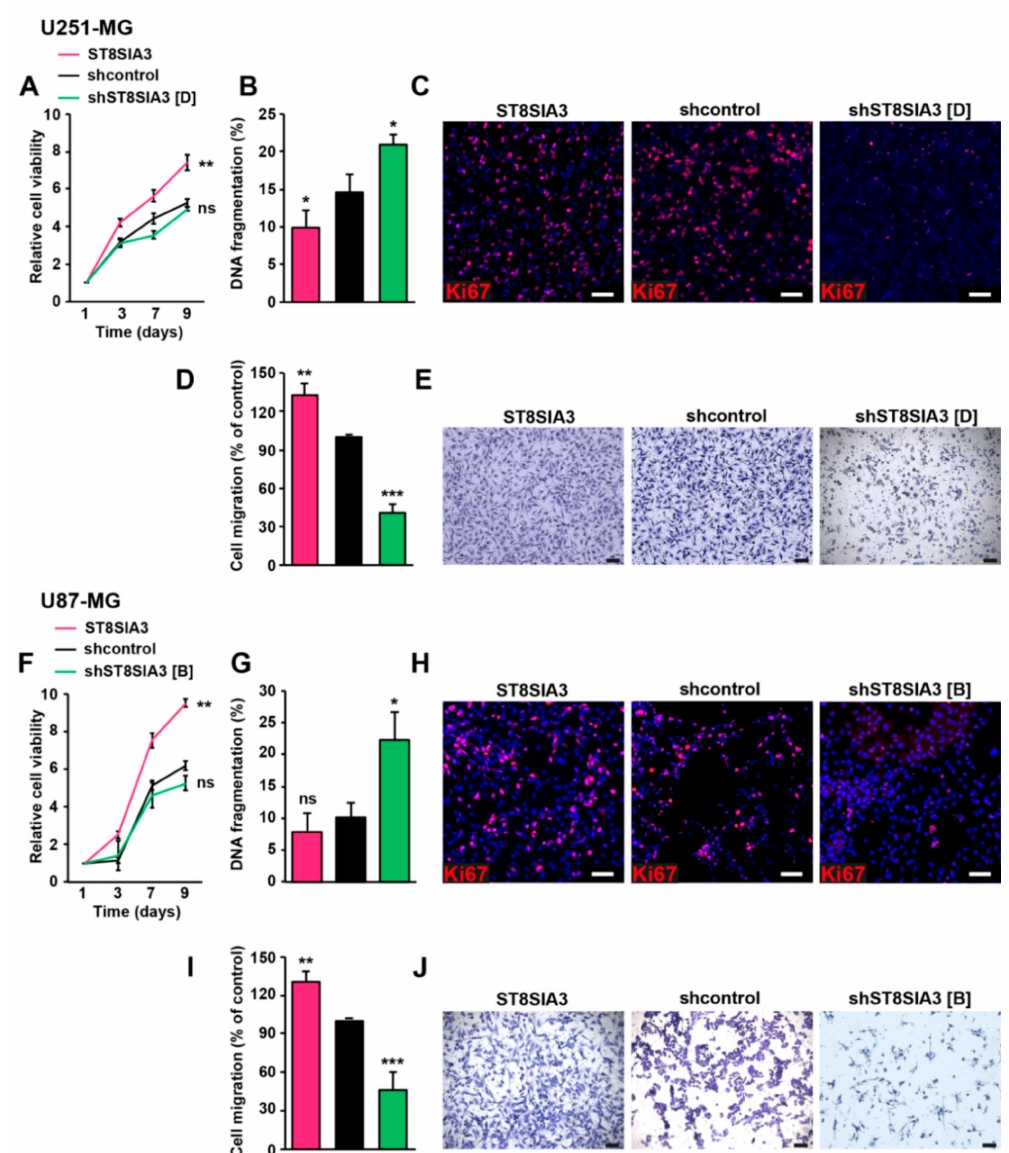
Figure 2. ST8SIA3 modulates in vitro cell death, proliferation, and migration. ( A , F ) Colorimetric MTT assay (3-(4,5-dimethylthiazol-2yl)-diphenyl tetrazolium bromide) was performed to compare cell viability ( n = 5 for each cell line). ( B , G ) DNA fragmentation (sub / G 1 ) was determined by flow cytometry of propidium-iodide-stained nuclei. Data are expressed as mean ± SEM deduced from five independent experiments. ( C , H ) Immunofluorescence staining of the proliferation marker Ki67 (red) in ST8SIA3, shcontrol, and shST8SIA3 cell lines. Cell nuclei are counterstained in blue. Scale bar = 50 µ m. ( D , I ) Quantification of cell migration using the transwell assay determined by the optical density of SDS-solubilized crystal violet. The mean + SEM values of four independent experiments, each performed in duplicate, are shown. ( E , J ) Representative phase contrast images of migrating cells. Scale bar = 50 µ m. Non-parametric Wilcoxon-Mann-Whitney test shows * p < 0.05, ** p < 0.01, and *** p < 0.001. ns: